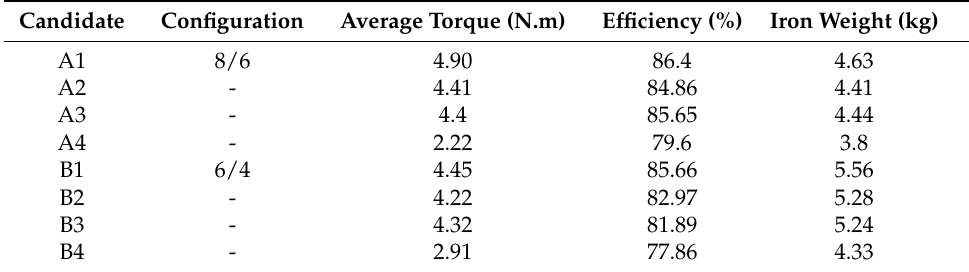
Table 4. Candidates in first non-dominated front (rank